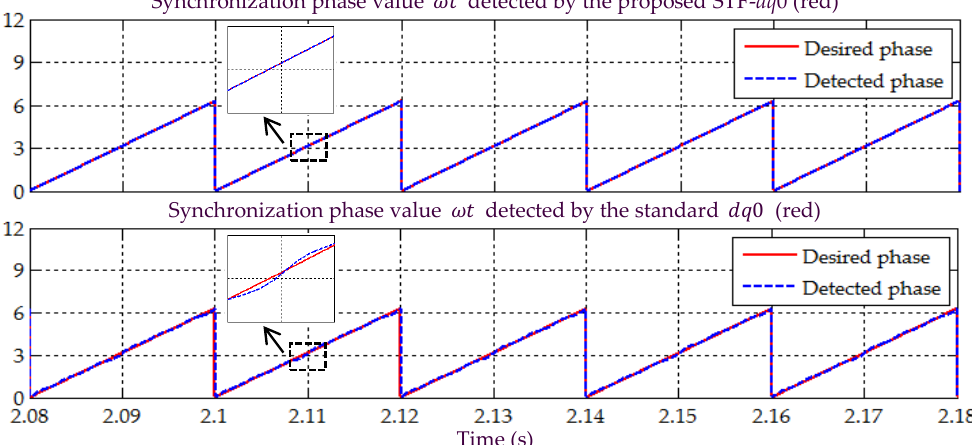
Figure 20. Simulation result showing the detected synchronization reference phase value 𝜔𝑡 under Scenario D.